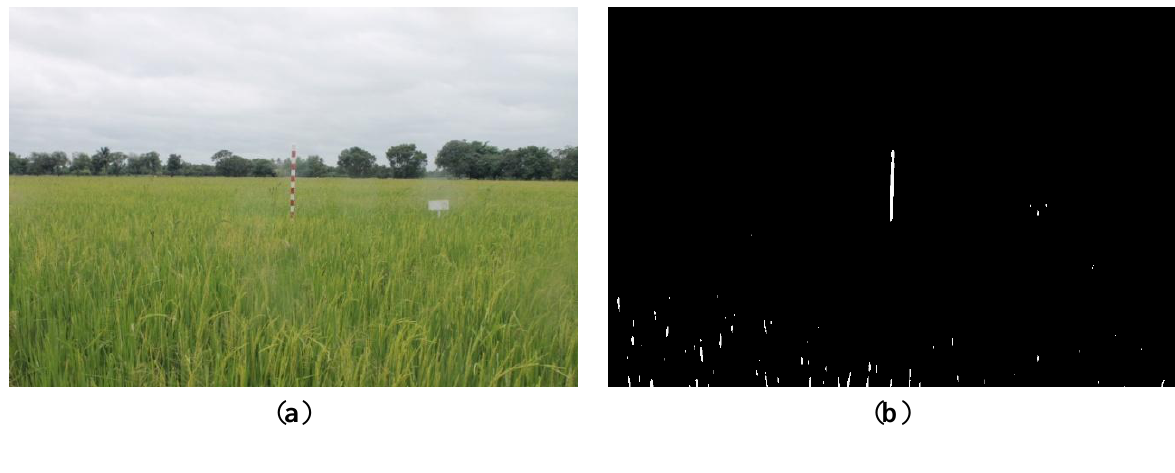
Figure 20. Comparison between ( a ) RGB and ( b ) resultant binary images using proposed method with excess green feature on 19 July